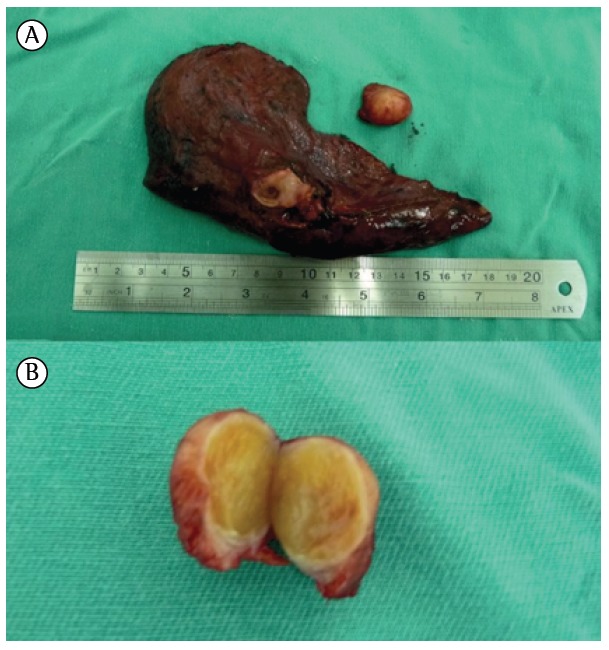
 Em A, fotografia do lobo superior direito e da lesão mediastinal
ressecados. Em B, fotografia da lesão mediastinal em destaque.